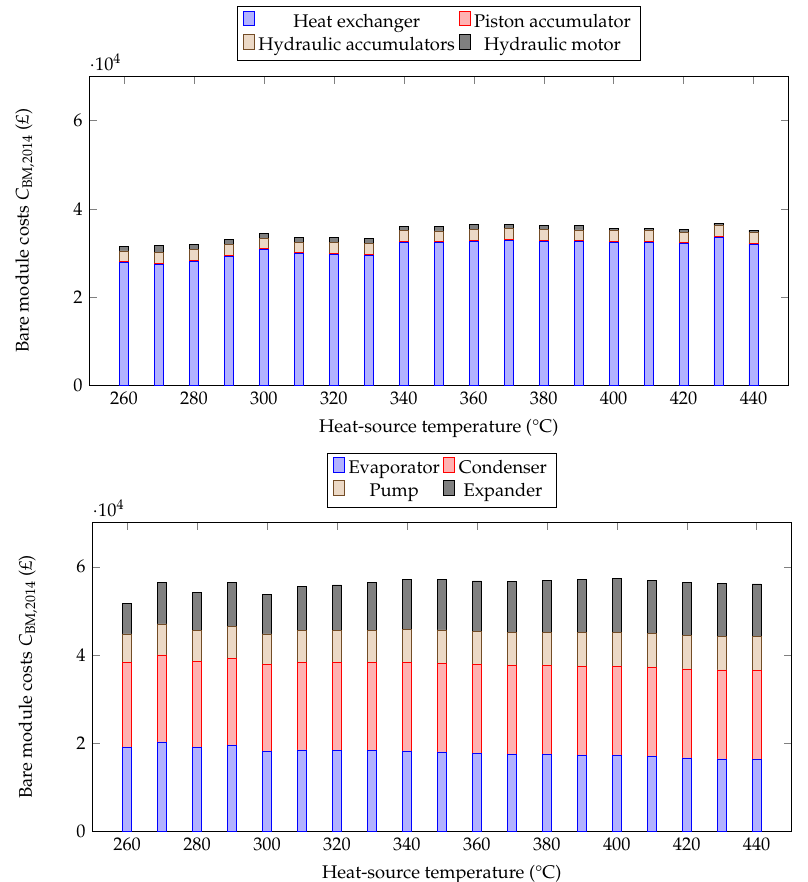
Figure 9. Bare module costs for n -hexane as the working fluid at different heat-source temperatures: ( a ) Up-THERM heat converter; and ( b ) equivalent ORC